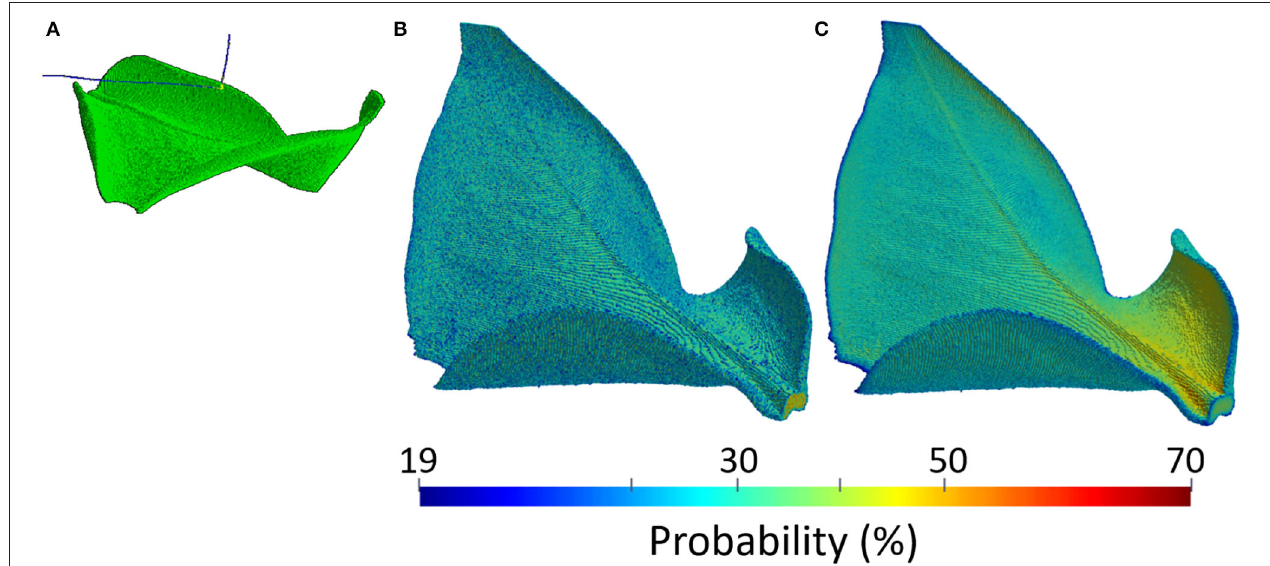
FIGURE 4 | Example of a physical model of a leaf of Epipremnum Aureum: simulation of a positron escape in GEANT4 (A) , positron annihilation probability (B) , and positron contamination probability (C)